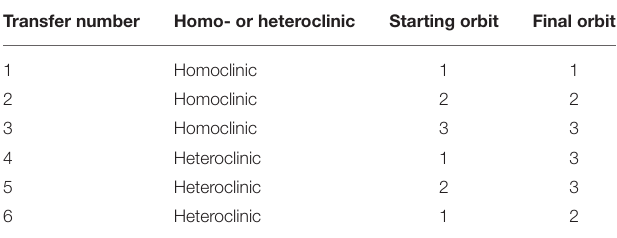
TABLE 1 | Homo- and heteroclinic connections to be